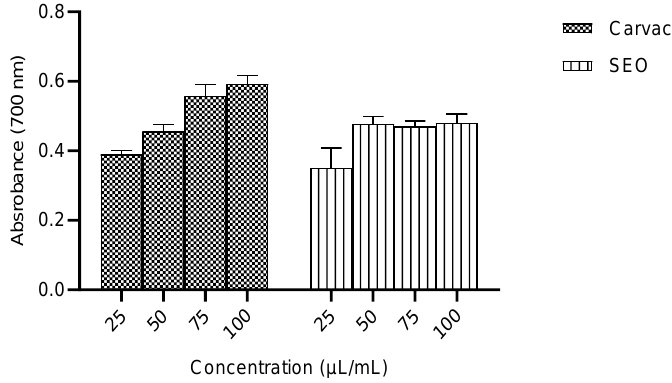
The residual concentration of carvacrol was compared to BHT to ascertain the impact of thermal exposure. The percentage areas for carvacrol and BHT were 37.32 and 53.09%, respectively, with carvacrol having a lower retention time. The GC-MS results are pre- sented in Tables 4 and 5. Table 4. GC-MS analysis of 2% carvacrol solution after thermal treatment for 15 min.